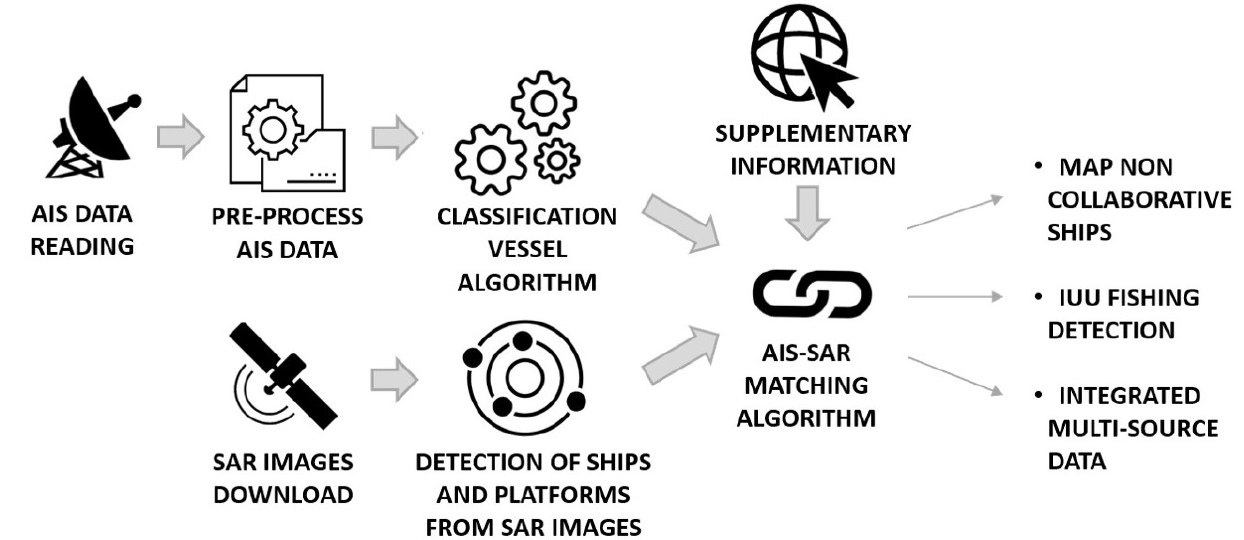
Figure 2. Flowchart to integrate AIS data and SAR